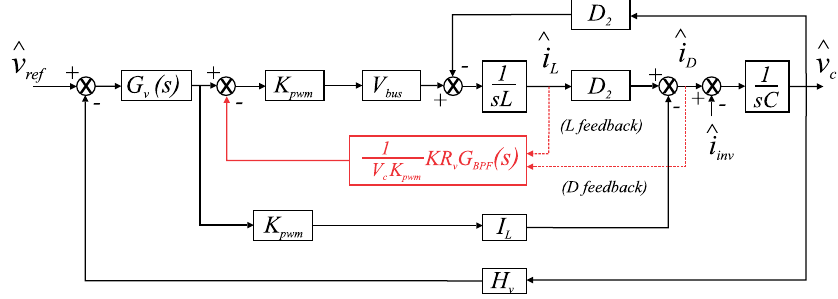
Figure 24. Bandpass filter inductor current feedback scheme.